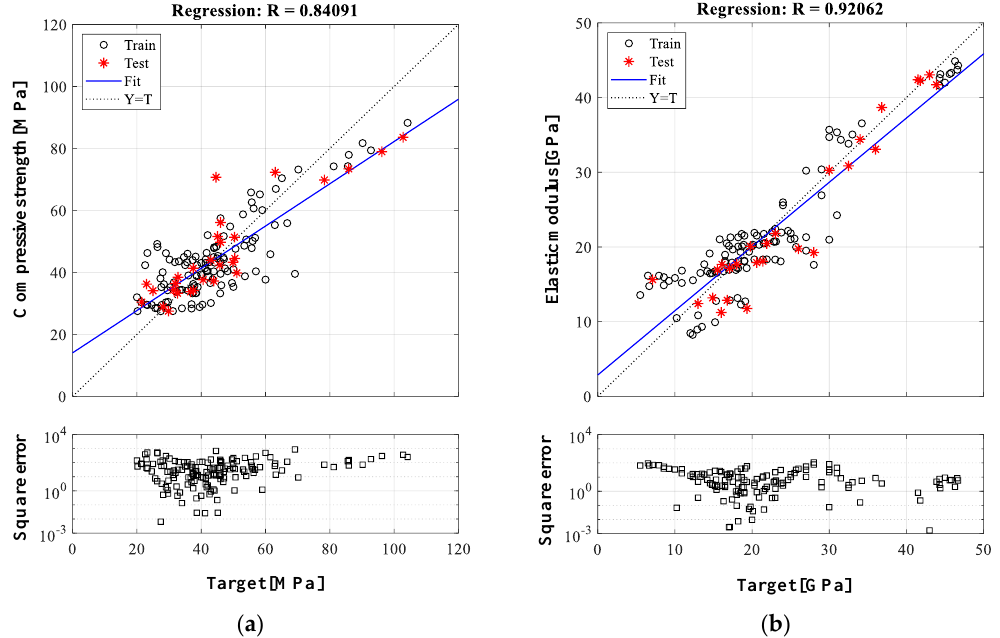
Figure 5. Prediction results from multiple linear regression (MLR)-based analysis: ( a ) compressive strength and ( b ) elastic modulus.